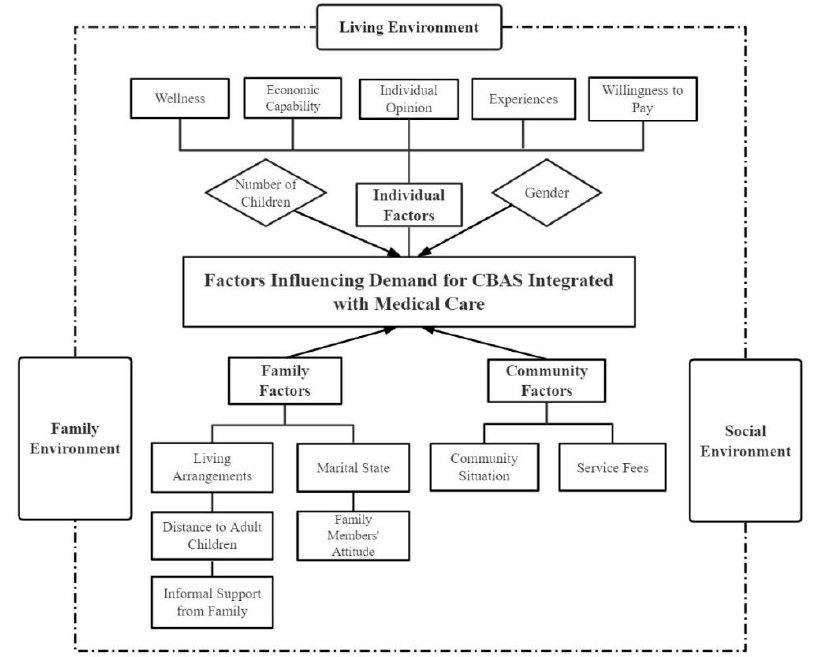
Figure A2. Difference in the factors influencing demand for CBAS integrated with medical care by number of children.